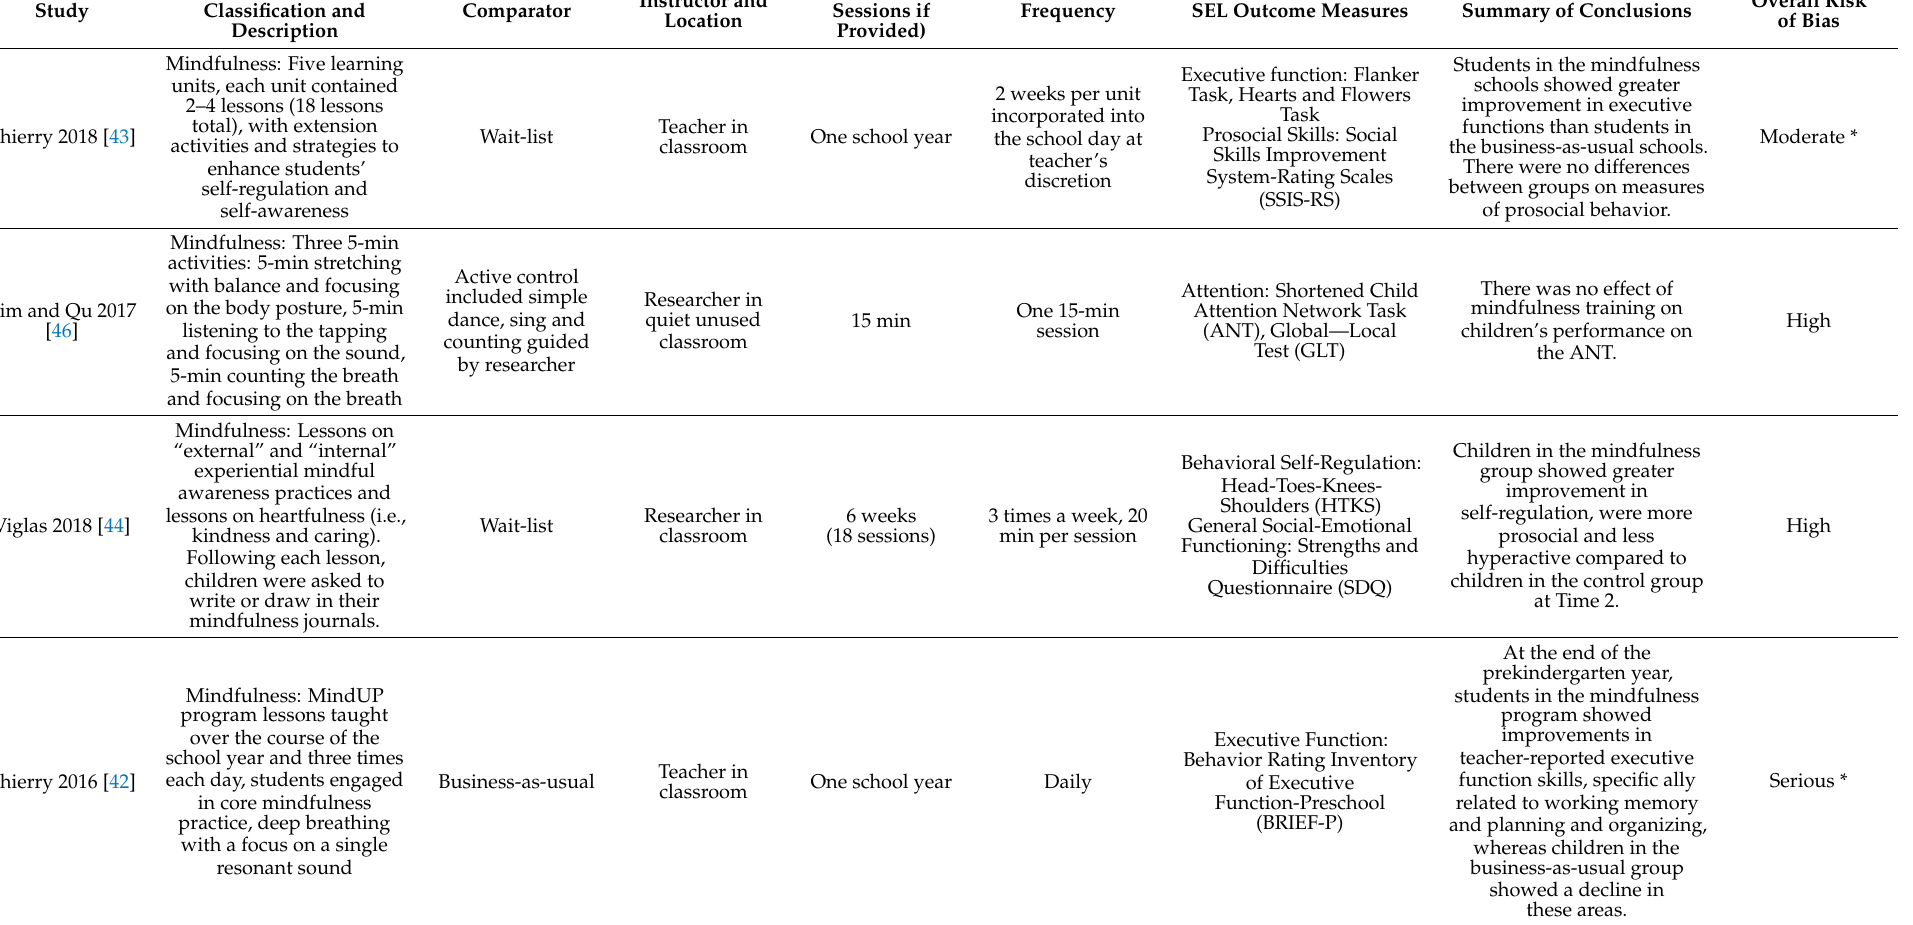
Table 2. Intervention Implementation and